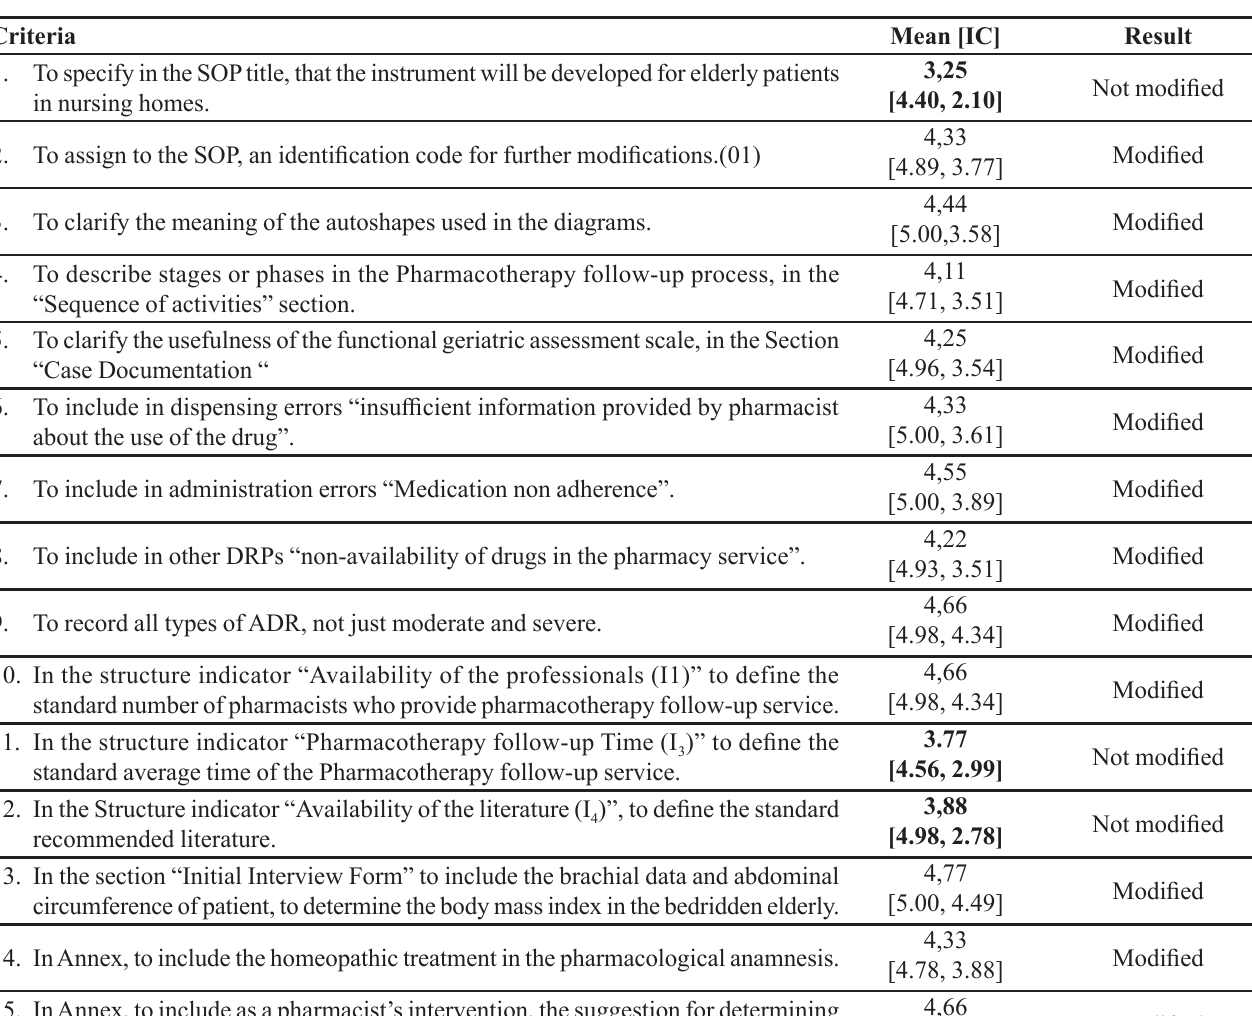
TABLE V - Assessment results by experts in the second round